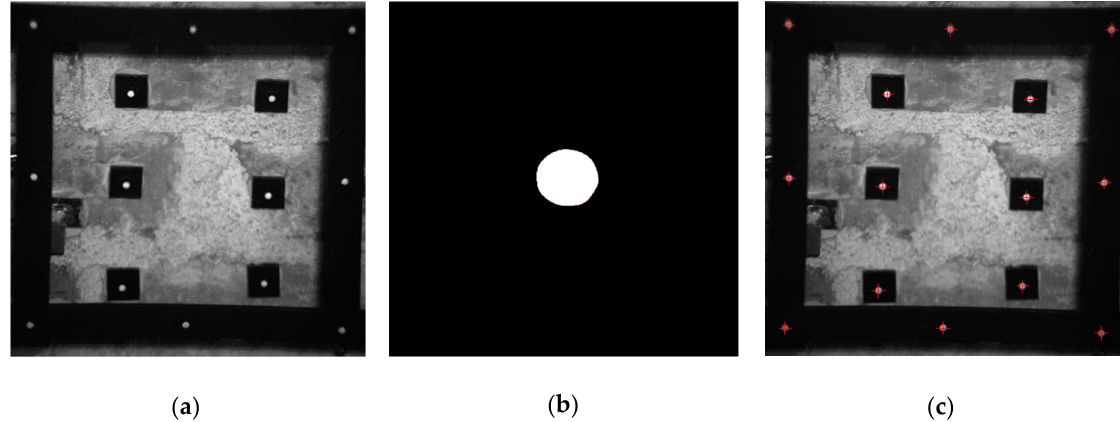
Figure 7. Target digital image processing: ( a ) original image; ( b ) binary image for one of the targets; ( c ) image with centroids.